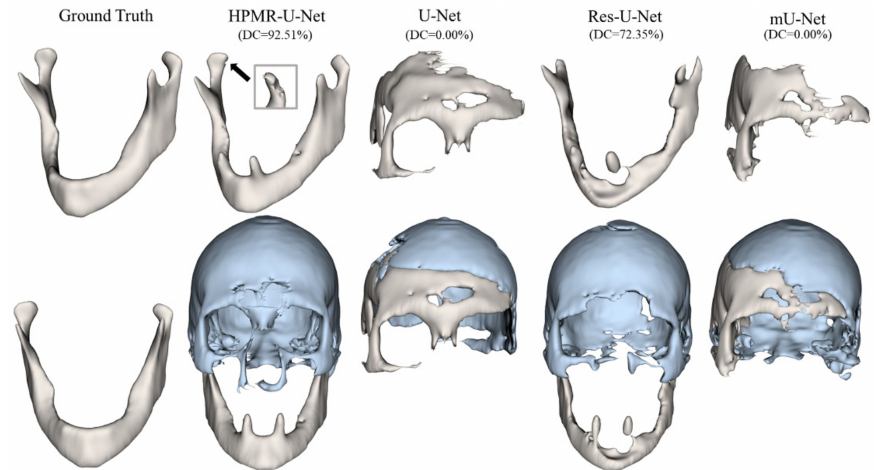
Figure 6. Sample case in the PDDCA dataset. White and blue indicate the mandible and maxilla, respectively. PDDCA has no maxilla ground